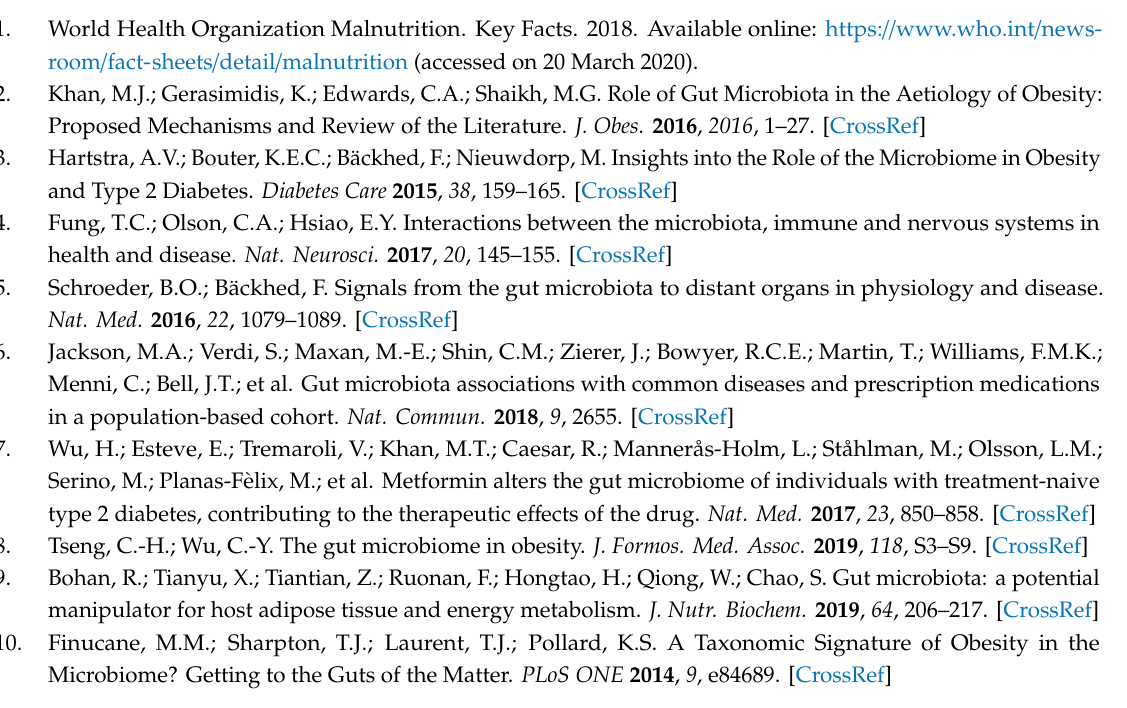
Figure S1: Alpha diversity as e ff ective number of species by Simpson index in men and women; Table S1: Extended benchmark data on total study population ( n = 1923); Table S2a. Comparison of levels of prevalence in waist–height ratio; Table S2b. Comparison of levels of relative abundance; Table S3. Comparison of pseudocounts; Table S4: